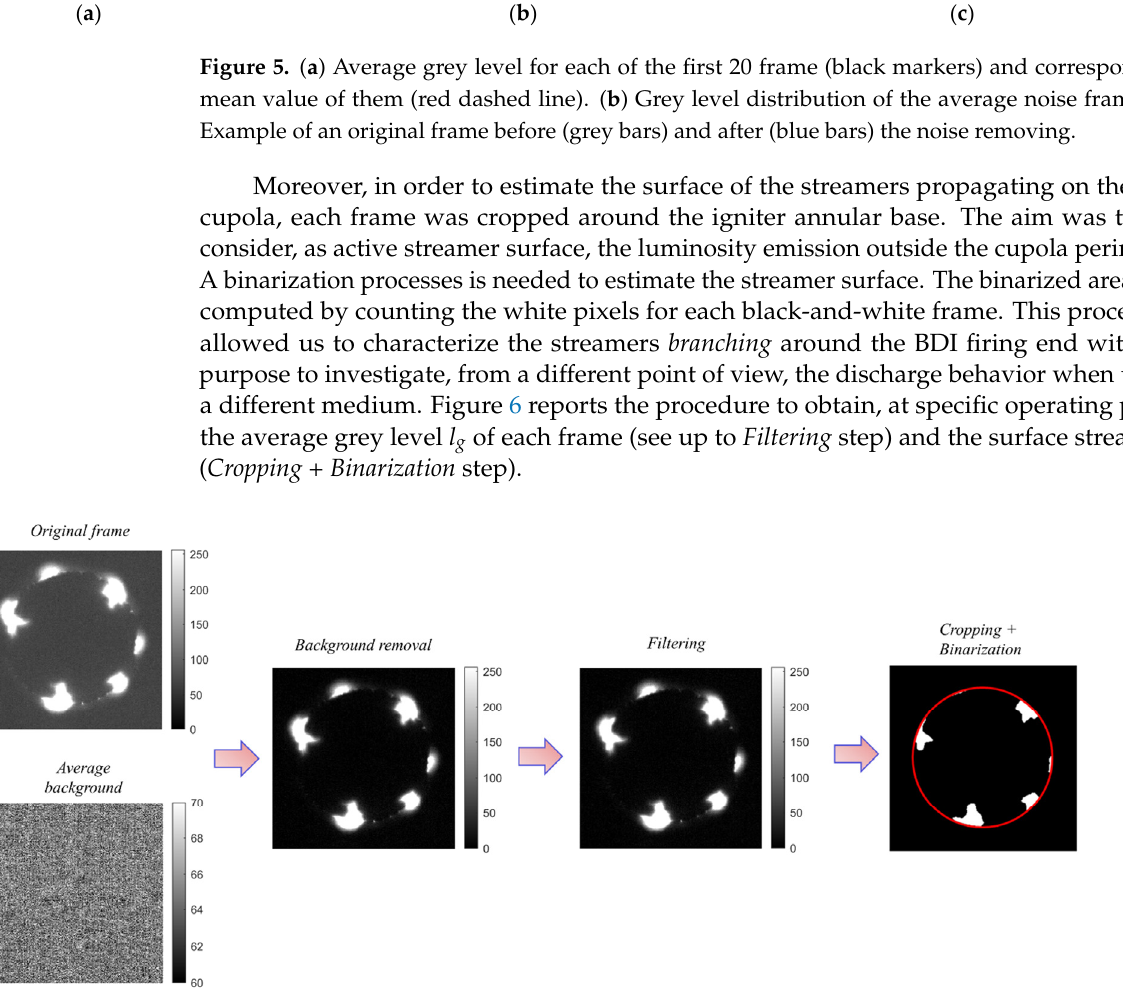
Figure 6. Workflow to obtain, at specific operating point, the average grey level and the binarized area for estimating the streamer surface around the igniter cupola.